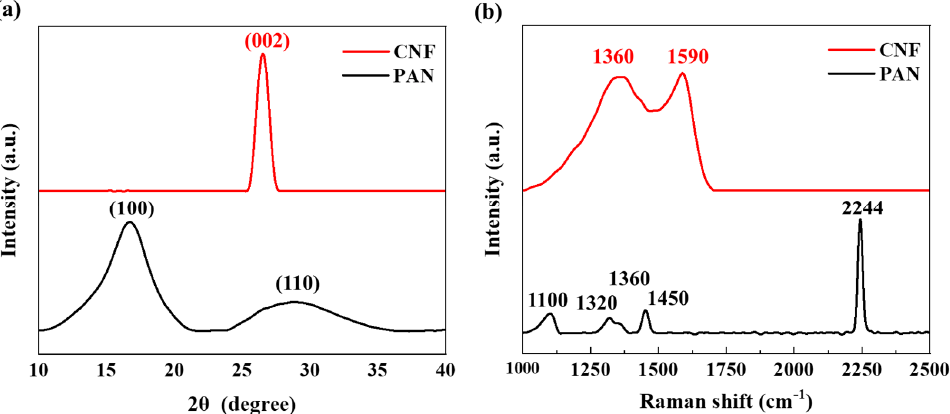
Figure 3. ( a ) XRD spectra and ( b ) Raman curves of PAN nanofibers and CNFs.